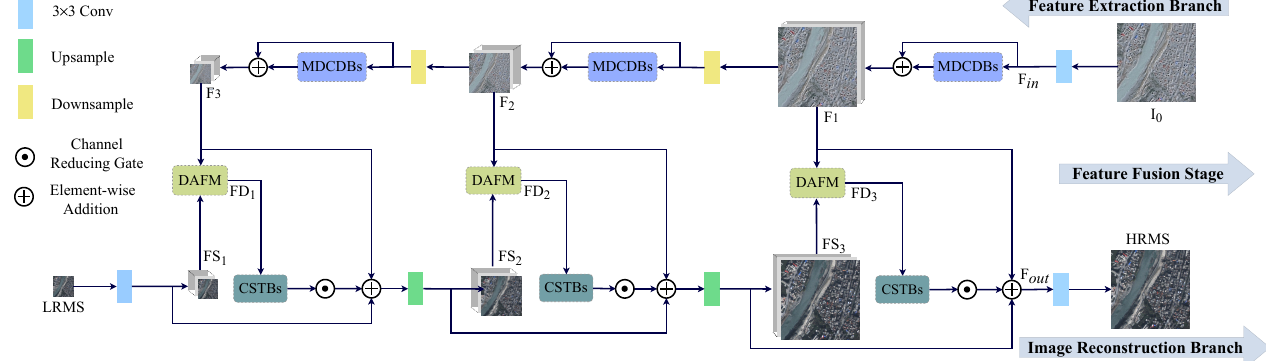
Figure 2. Network architecture of MPFINet. The gray arrows point to the direction of increasing